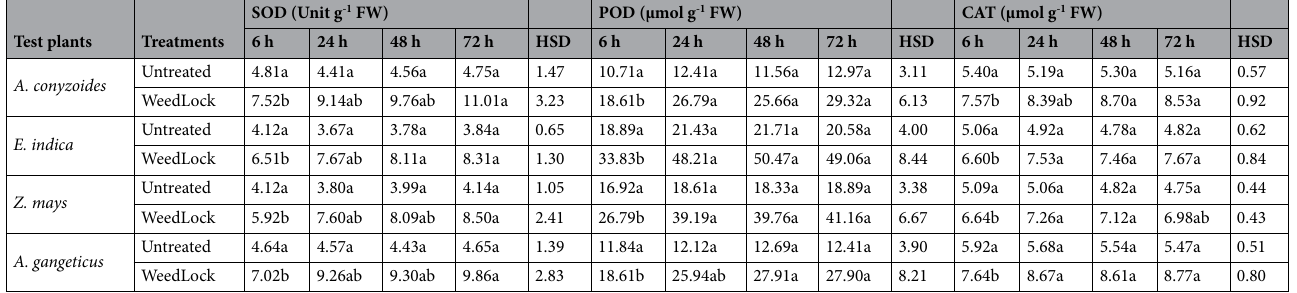
Table 4. Effect of WeedLock on antioxidant enzyme activity of test plants. Means having different letters differ significantly at p <